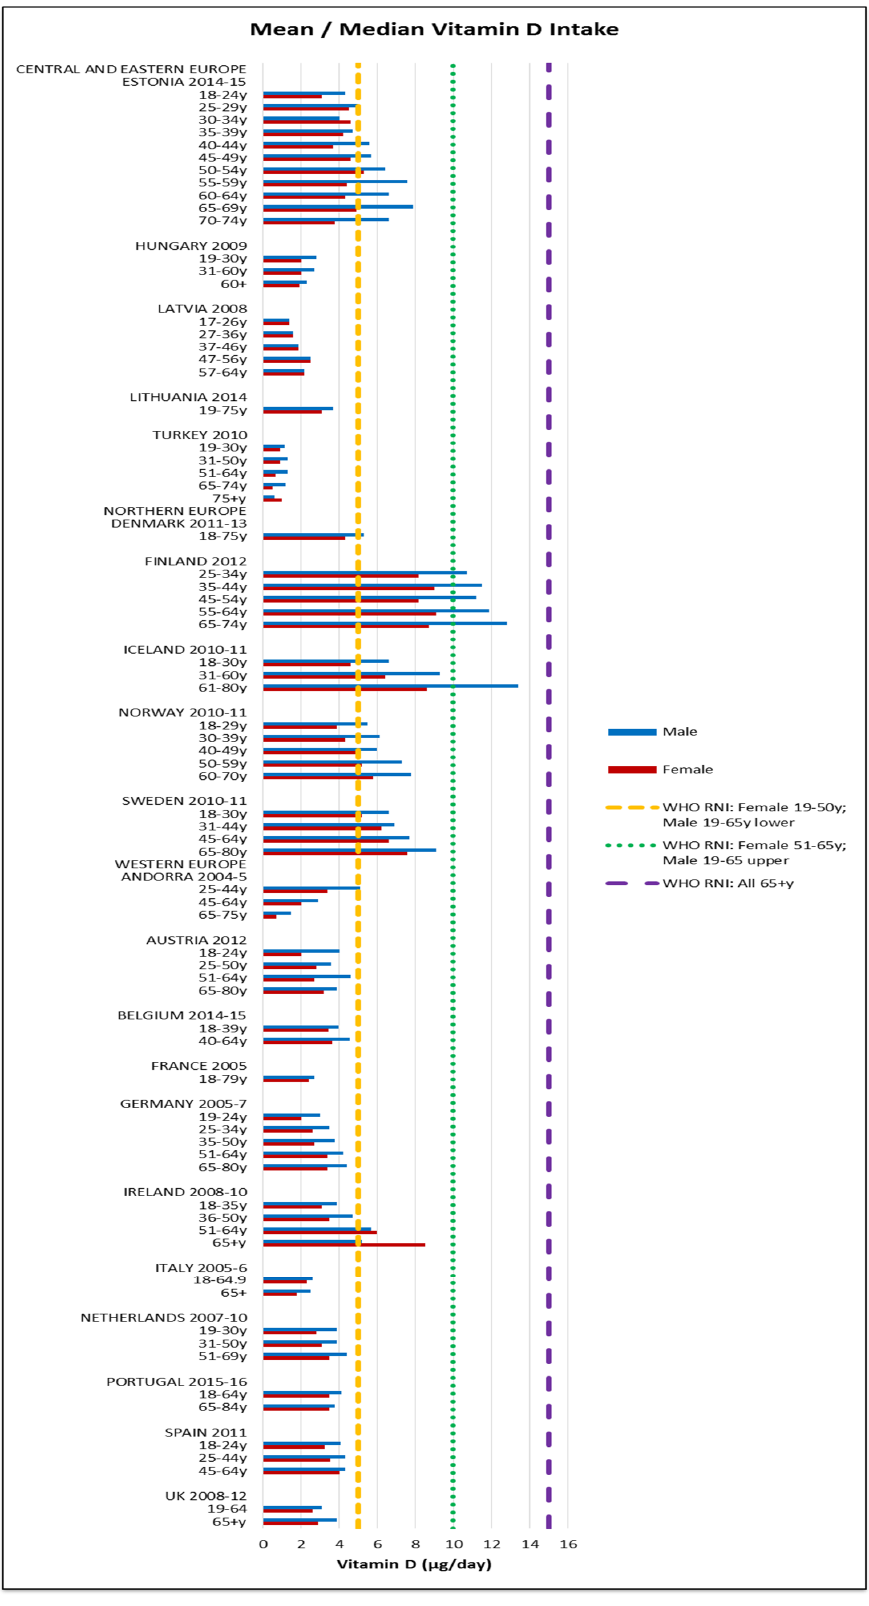
Figure 14. Mean/median* adult vitamin D intake ( μ g/day) (excluding supplements). * Figures for Spain are based on median rather than mean values.